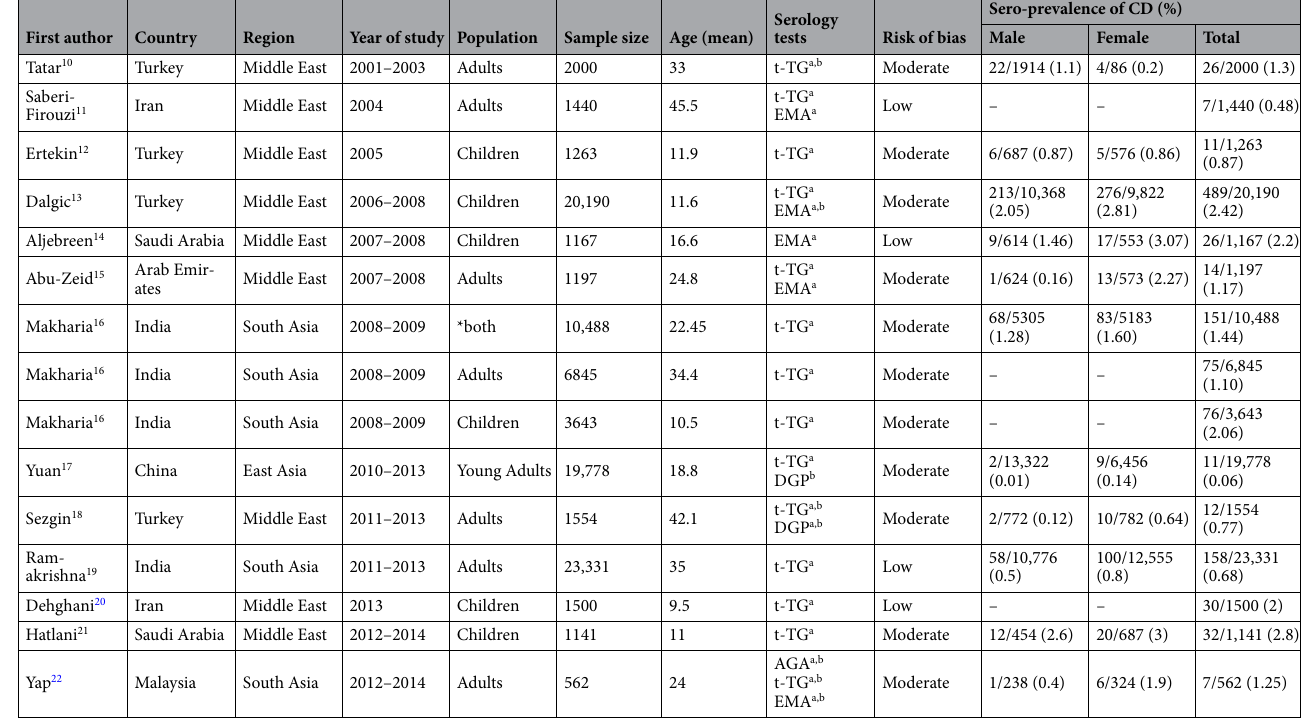
Table 1. Sero-prevalence of CD in Asian-Pacific region among not at-risk population. EMA Anti-endomysial antibodies, AGA Anti-gliadin antibodies, t‑TG tissue transglutaminase, DGP deamidated gliadin peptides. a IgA. b IgG. *Adults and children together.